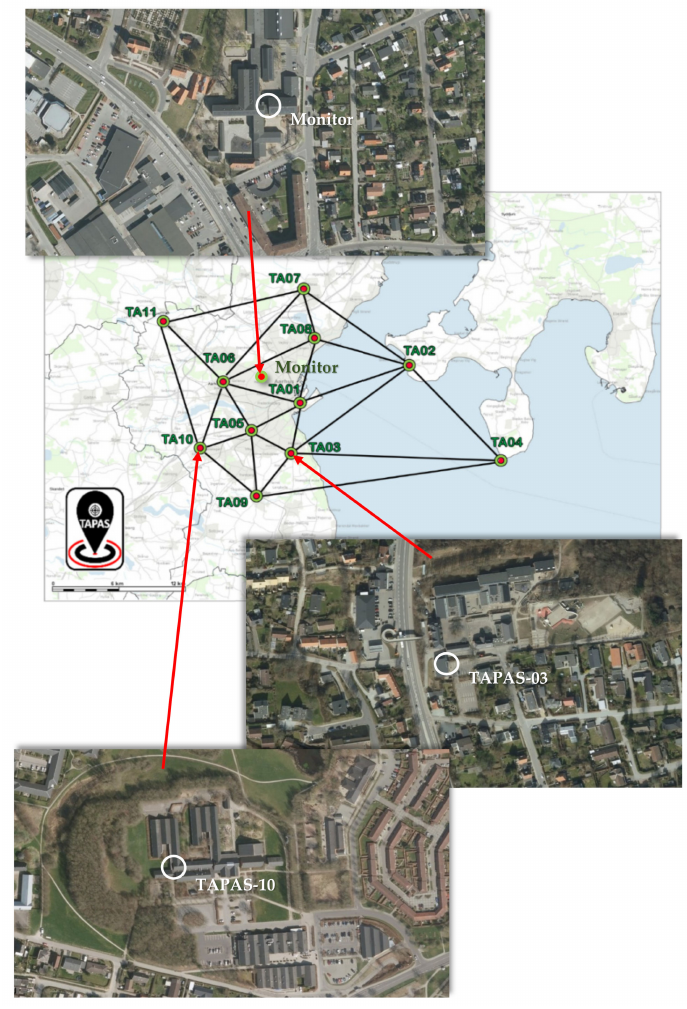
Figure 1. The TAPAS real-time kinematic (RTK) network around the city of Aarhus, with zoomed in view on the location of stations TA03 and TA10 as well as the monitoring station © The Danish Agency for Data Supply and Efficiency